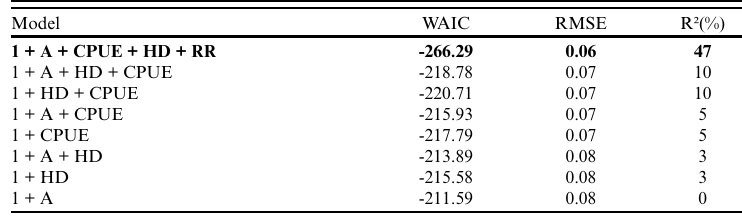
Table 5 . Comparison of the models used. Statistics acronyms are: WAIC = Watanabe-Akaike information criterion; RMSE = root mean square error; R² = adjusted coefficient of determination (%). Predictors acronyms are: Age = fisher’s age, CPUE = mean catch per unit effort (kg/h), HD = household fishing economic dependence, and RR = reserve random effect. The best model is highlighted in